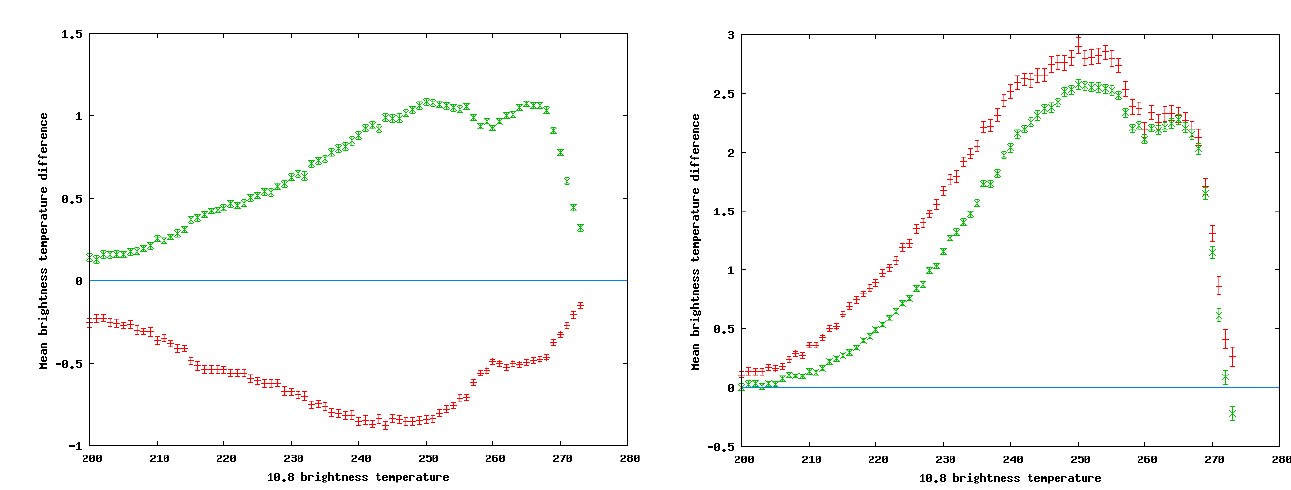
Fig. 2a. Difference of the mean value of 08.7µm and 12.0µm Figure 2.a. Difference of the mean value of 08.7 µm and 12.0 µm channels between non rainy and rainy channels between non rainy and rainy pixels plotted versus 10.8µm pixels plotted versus 10.8 µm brightness temperature in red and green respectively. Curves are plotted brightness temperature in red and green respectively. Curves are with error-bars. Both scales are in Kelvin. plotted with error-bars. Both scales are in Kelvin.